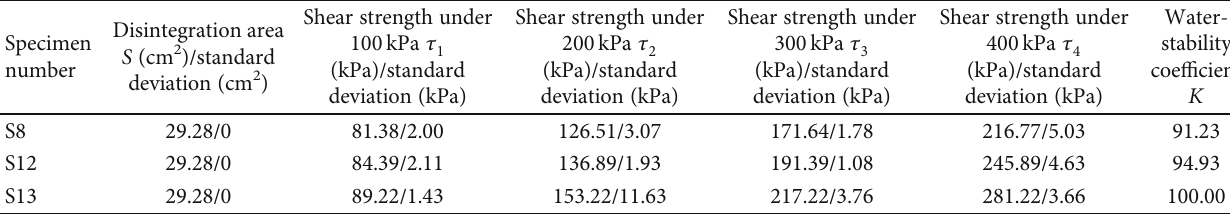
Table 4: The results of the test with di ff erent density.